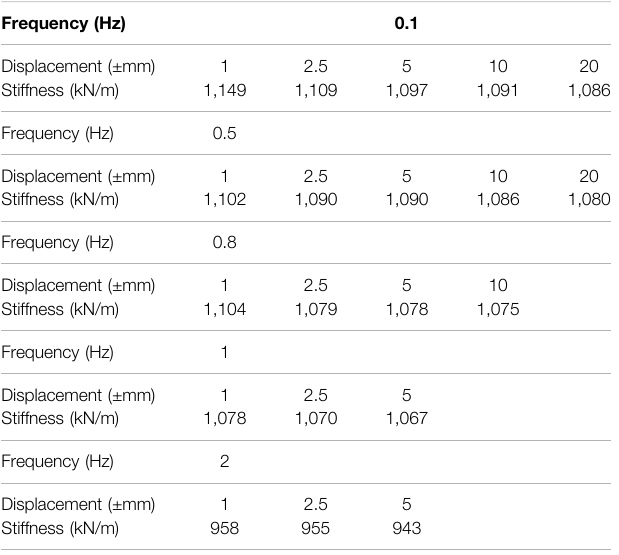
TABLE 2 | Experimental value of frequency-dependent vertical stiffness of air spring.